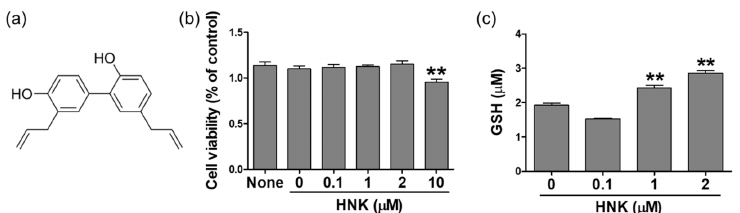
Figure 1. The structure of honokiol (HNK) and the cell viability and glutathione (GSH) content in human kidney ‐ 2 (HK ‐ 2) cells. ( a ) A chemical structure of honokiol. ( b ) Cells were treated with honokiol (0, 0.1, 1, 2, or 10 μ M) for 24 h and MTT assays were performed. ( c ) Cells were treated with honokiol (0, 0.1, 1, or 2 μ M) for 24 h and the GSH levels were determined. Values are expressed as the means ± S.E.M. of three independent experiments. ** p < 0.01 compared with the vehicle control.